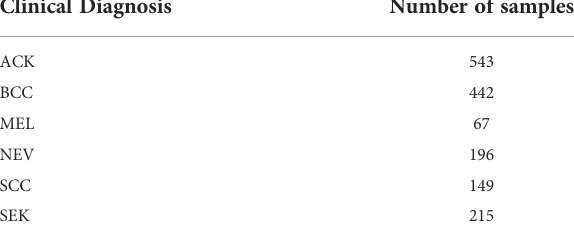
TABLE 1 Distribution of skin disease samples was analyzed by PAD-